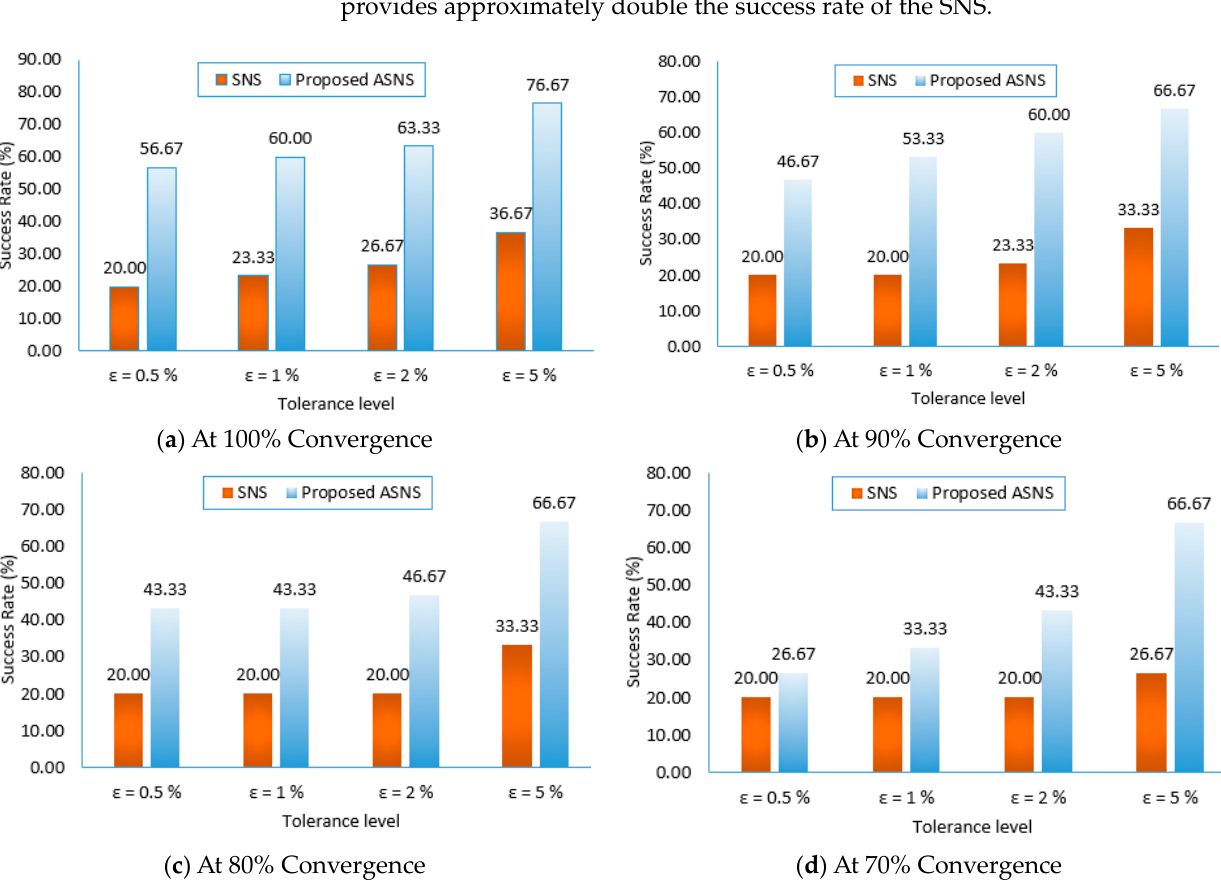
Table 15. Absolute di ff erence between the best and worst of SNS and ASNS for minimizing the losses (Case 1) for the IEEE 30-bus system.